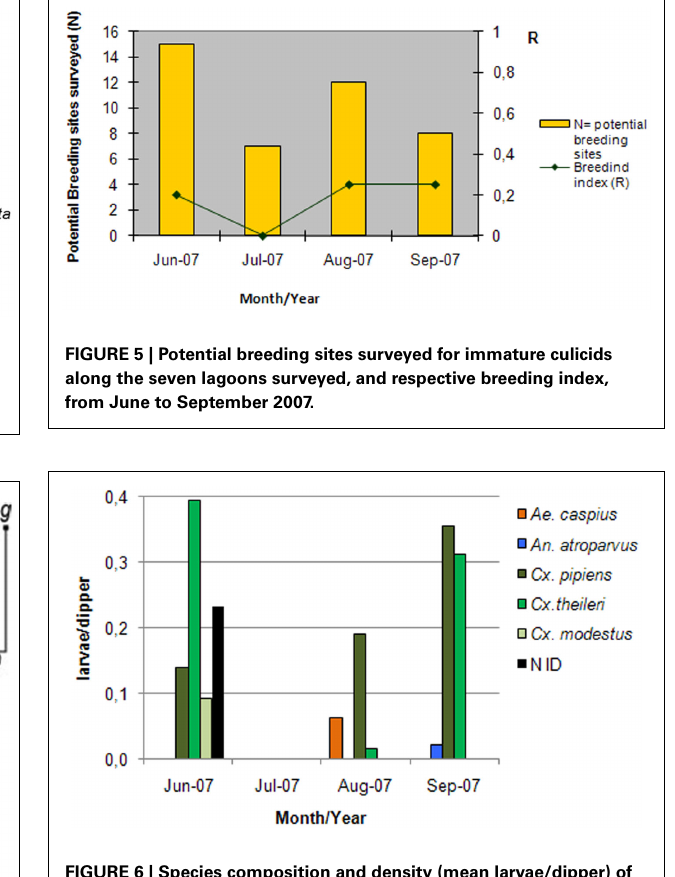
FIGURE 6 | Species composition and density (mean larvae/dipper) of the culicid immature forms collected along the lagoons surveyed. A total of 85 larvae were collected. No larvae were collected in the margins of natural lagoons.